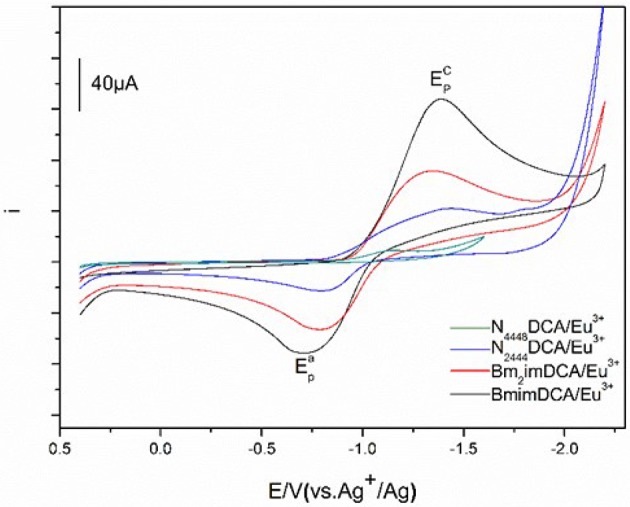
Cyclic voltammograms of Eu(III) measured in [C4mim][N(CN)2] (black), [C4m2im][N(CN)2] (red), N4442[N(CN)2] (blue), and N8444[N(CN)2] (green) at 303 K.